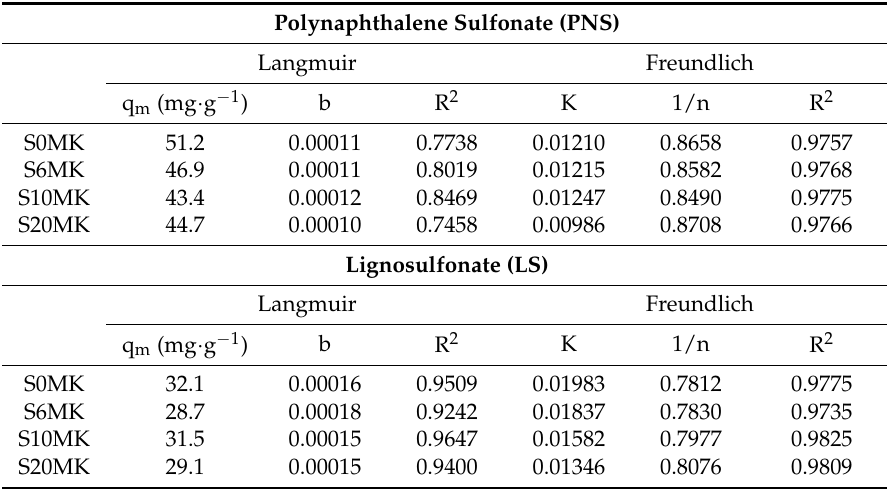
Table 3. Results of adsorption isotherms onto air lime suspensions at different MK percentages: Langmuir and Freundlich adsorption parameters for both SPs.